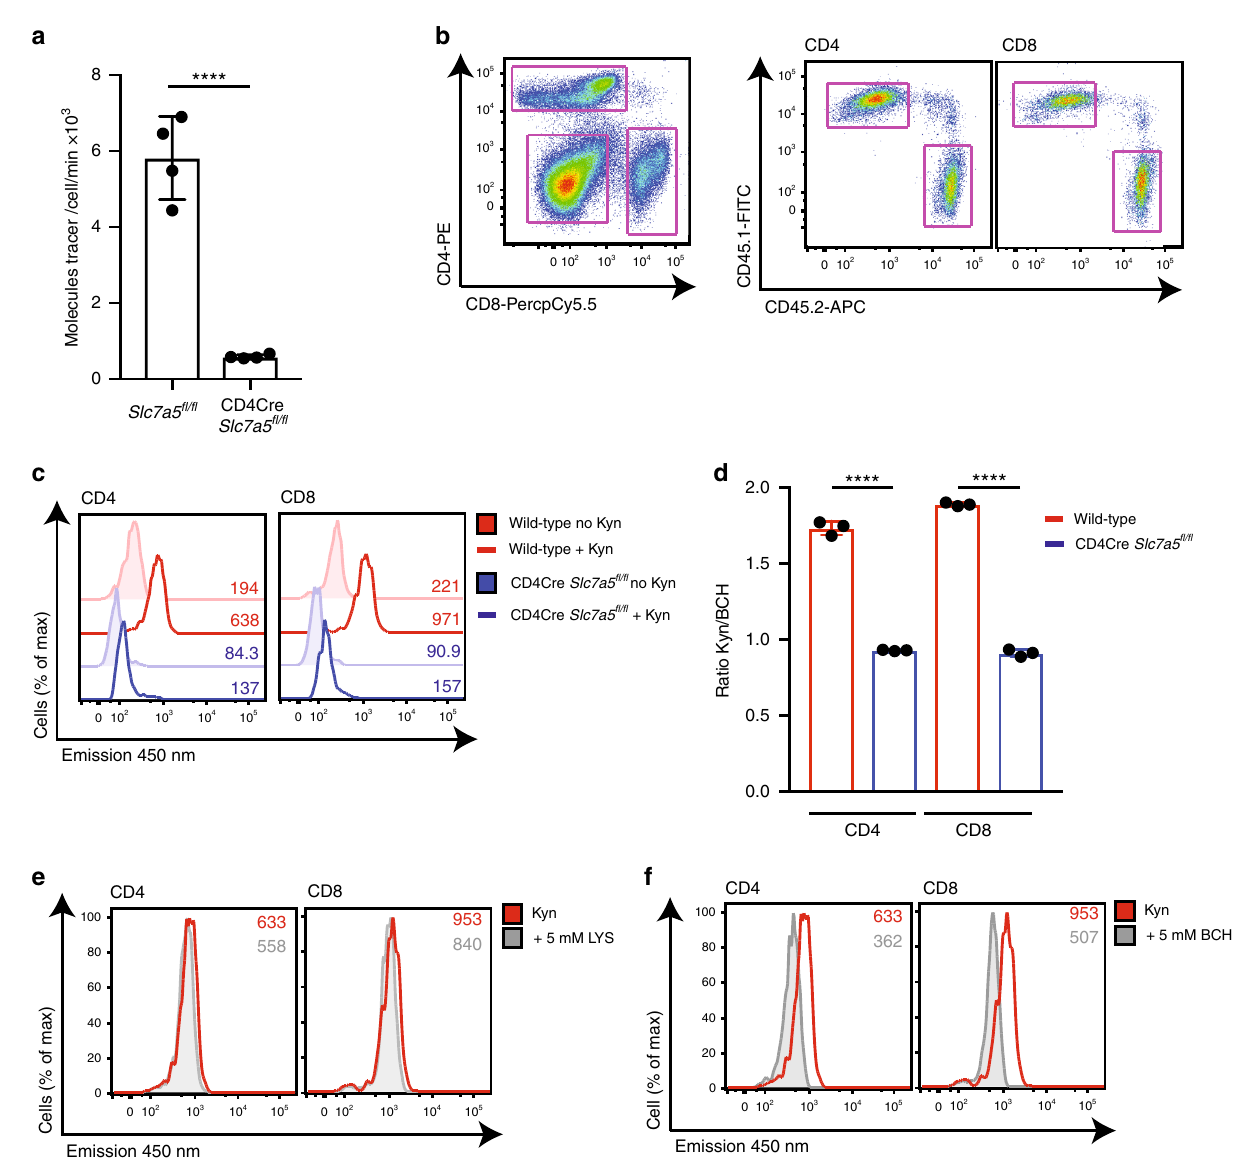
Fig. 4 SLC7A5 mediates kynurenine transport in activated T cells. a Uptake of 3 H-kynurenine in TCR-stimulated (CD3/CD28, 18 h) CD4 + T cells from Slc7a5 fl / fl or CD4Cre + Slc7a5 fl / fl mice. b – d Wild-type (CD45.1) and CD4Cre + Slc7a5 fl / fl (CD45.2) splenocytes were mixed 1:1 and activated using CD3/ CD28 antibodies for 24 h. b The data show representative fl ow cytometry pro fi les of the gating strategy used to identify CD4 + , CD8 + (left panel) and subsequent CD45.1 + and CD45.2 + subpopulations (right panel). c The overlaid histograms show 450 nm emission in wild-type and CD4Cre + Slc7a5 fl / fl CD4 + (left panel) or CD8 + (right panel) T cells after 4 min (37 °C) with or without kynurenine (200 μ M). MFIs are indicated. d Ratio of the 450 nm emission of T cells treated with kynurenine ± BCH 10 mM. e , f Histograms showing 450 nm fl uorescence emission of wild-type CD4 + (left panel) and CD8 + (right panel) T cells after 4 min kynurenine (200 μ M, 37 °C) uptake in the presence or absence of 5 mM lysine, a System y + L competitor ( e ); or 5 mM BCH, a System L inhibitor ( f ). Error bars are ±s.d. Individual points indicate biological replicates. MFIs are indicated in the histograms, data are representative of four ( a ) or three ( b – f ) biological replicates. P values **** = < 0.0001 (unpaired t -test, a ; ordinary one-way ANOVA, d